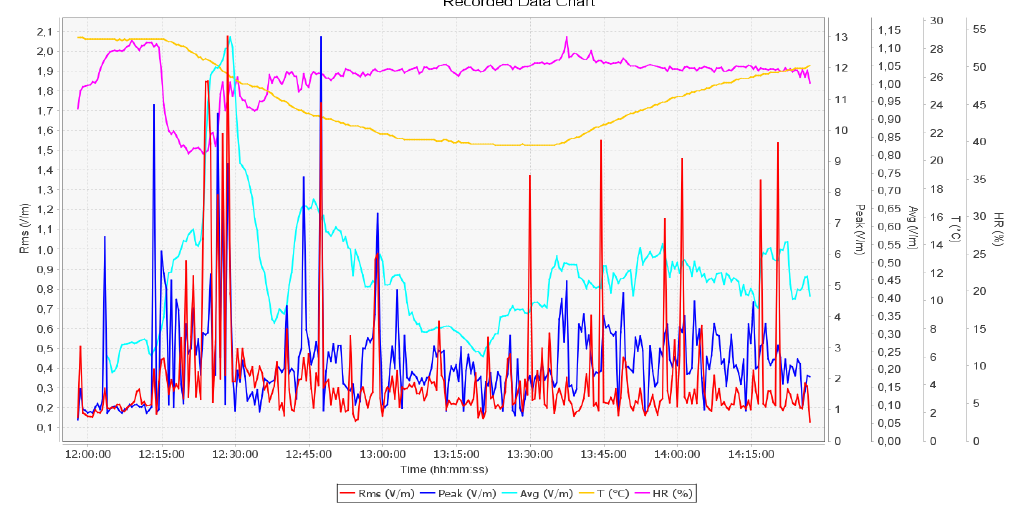
Figure 9. The intensity of the electrical component of the electromagnetic field in the course of a flight for the Tecnam P2006T flight no 1.